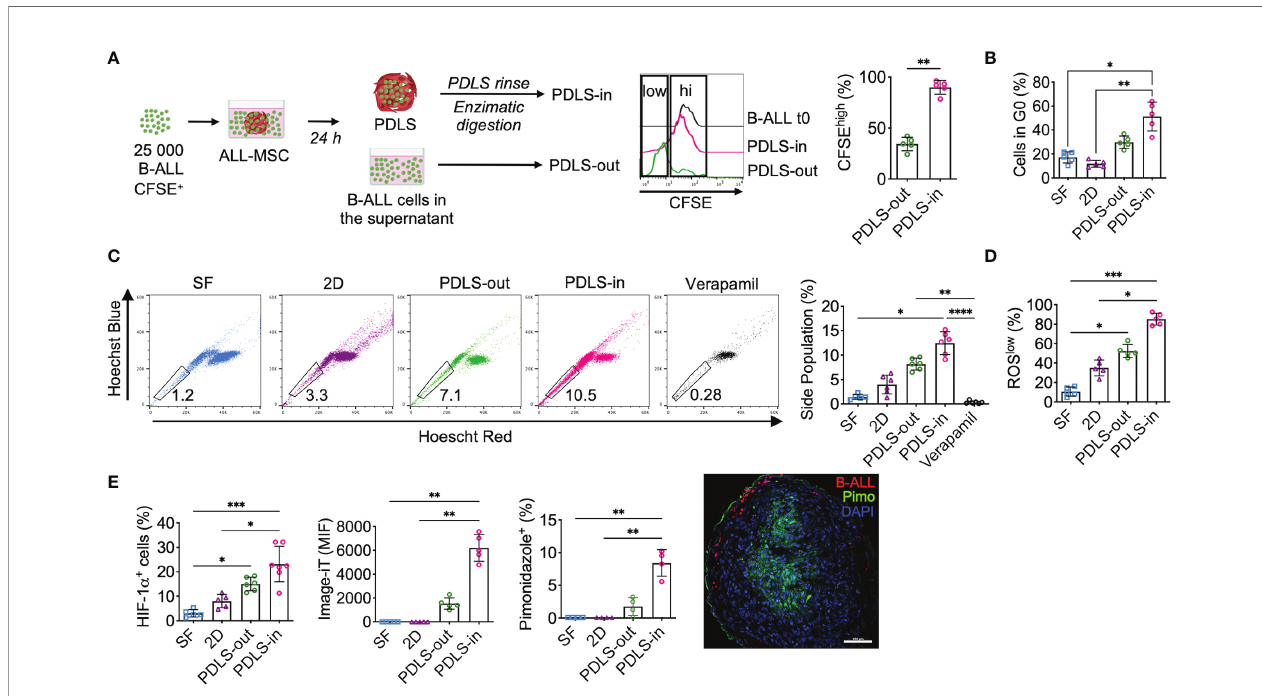
FIGURE 3 | PDLS promote stem cell-like phenotype, quiescence, and hypoxia in a subset of primary B-ALL cells. (A) Primary sorted B-ALL CD10 + CD19 + blasts were labeled with CFSE and co-cultured with ALL-MSC to form PDLS. At 24 h, frequency of CFSE hi was determined by FACS in the supernatants after spheroid removal (PDLS-out) and in the PDLS colonizer cells (PDLS-in) after several washes and enzymatic digestion ( n = 5). (B) Primary B-ALL blasts were cultured in stromal-free (SF) conditions and co-cultured with ALL-MSC in monolayer (2D) and PDLS settings for 48 h and cell cycle status was evaluated by Ki-67 staining and DNA content by FACS ( n = 5). (C) Side population cell contents are shown ( n = 5). (D) ROS production was measured by FACS and ROSlow frequency was recorded ( n = 5). (E) Hypoxia was investigated by HIF-1 a expression (left), image-iT fl uorescent hypoxia probe (middle) and pimonidazole incorporation (right) by FACS. Fluorescence microscopy of pimonidazole incorporation of PDLS is shown ( n = 7). MSC, mesenchymal stromal cell; B-ALL, B-cell acute lymphoblastic leukemia; PDLS, patient-derived leukemia spheroids; CFSE, carboxi fl uorescein; FACS, fl uorescence-activated cell sorting. *P < 0.05; **P < 0.01; ***P < 0.001, ***P < 0.0001. Error bars represent